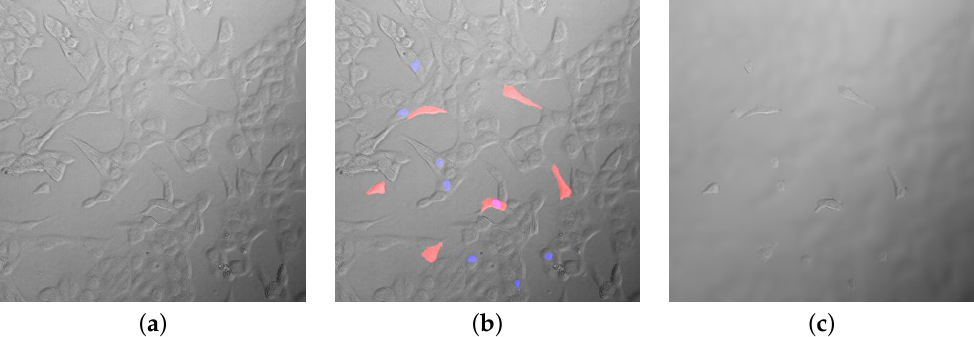
Figure 3. Example data from the EVICAN dataset [88]: ( a ) original image (ID 92_ACHN); ( b ) image with annotated cells (red) and nuclei (blue); ( c ) image where non-annotated areas have been blurred. fastER [25] includes PhC, BC, and synthetic Fluo images of three different cell